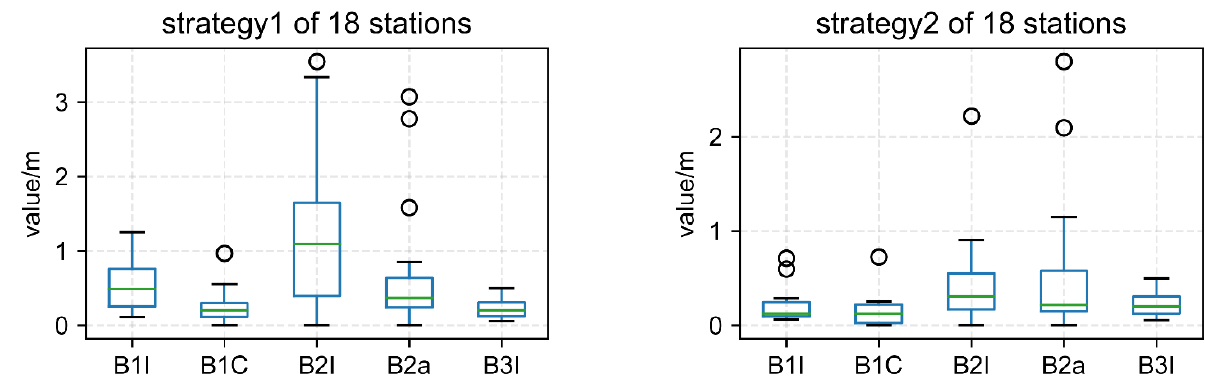
Figure 9. Average position value of 18